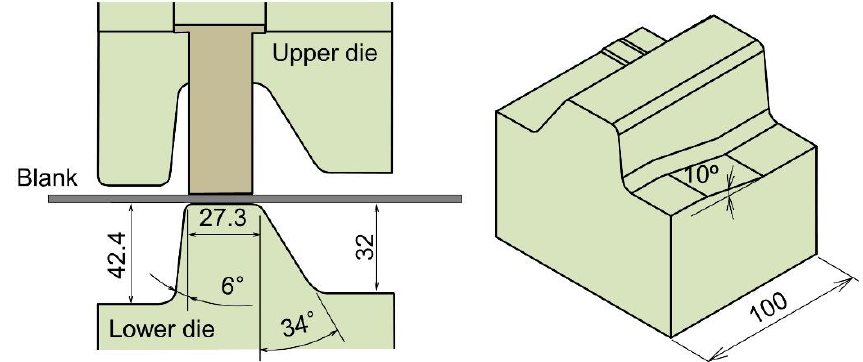
Figure 4. Dies used for hot stamping of hat-shaped bending.